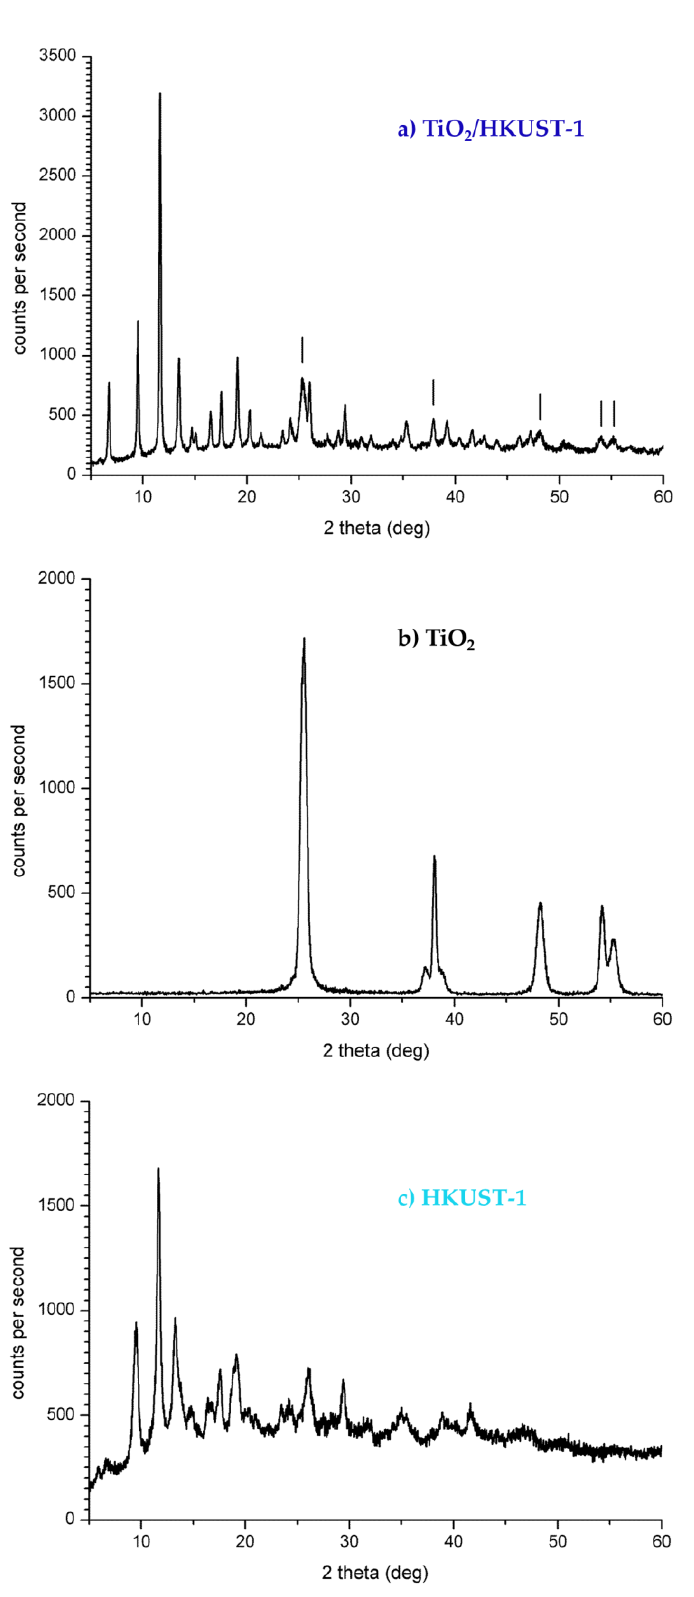
Figure 1. Powder X-ray diffraction (PXRD) pattern of ( a ) TiO 2 /HKUST-1 (overhanging bars correspond to the most intense diffraction peaks of anatase TiO 2 ), ( b ) TiO 2 and ( c ) HKUST-1.